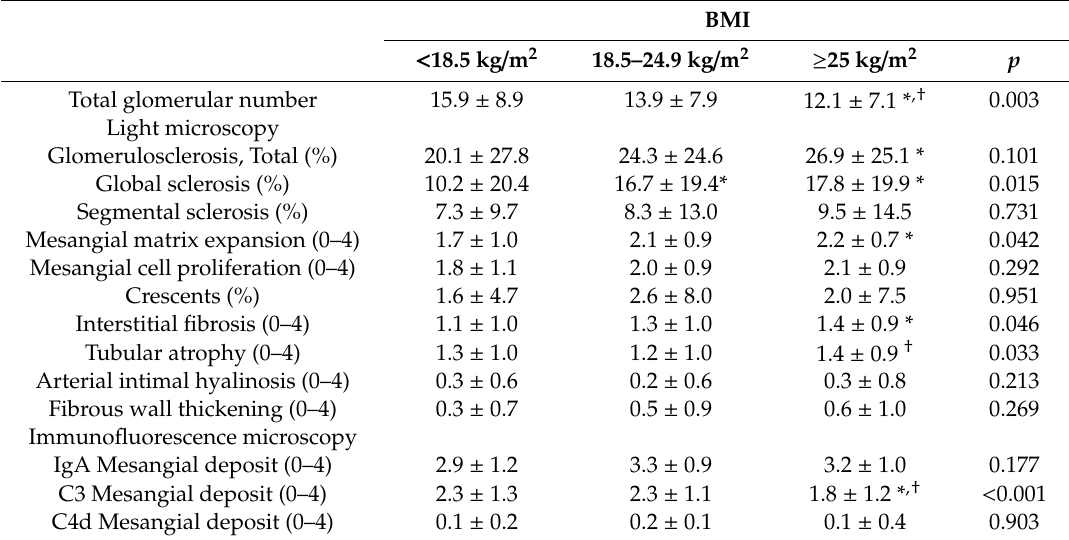
Table 2. Histopathological findings of the three BMI groups.